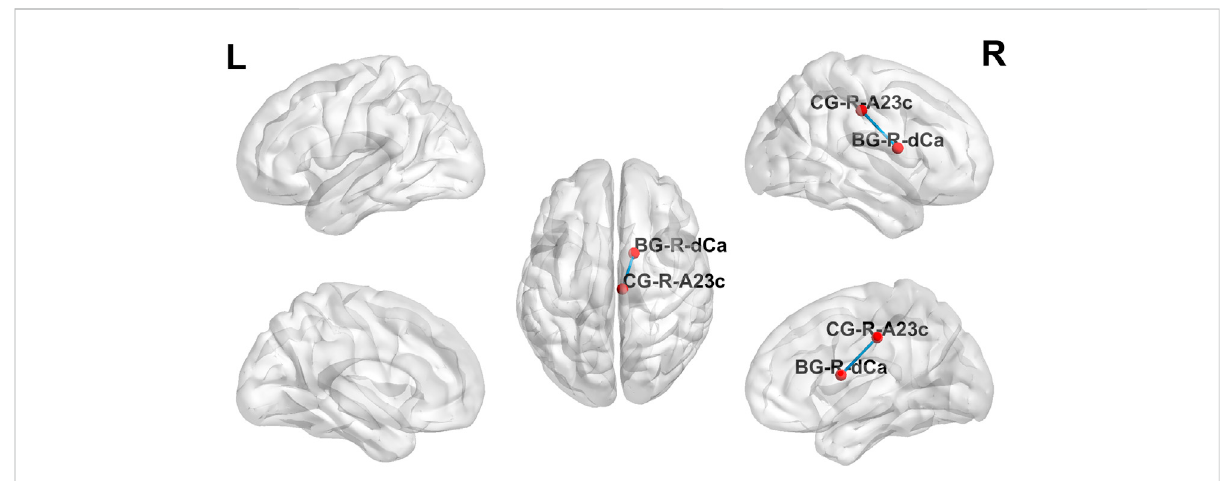
FIGURE 3 Brain functional network connectivity altered before and after dual-target rTMS intervention. BG, basal ganglia; CG, cingulate